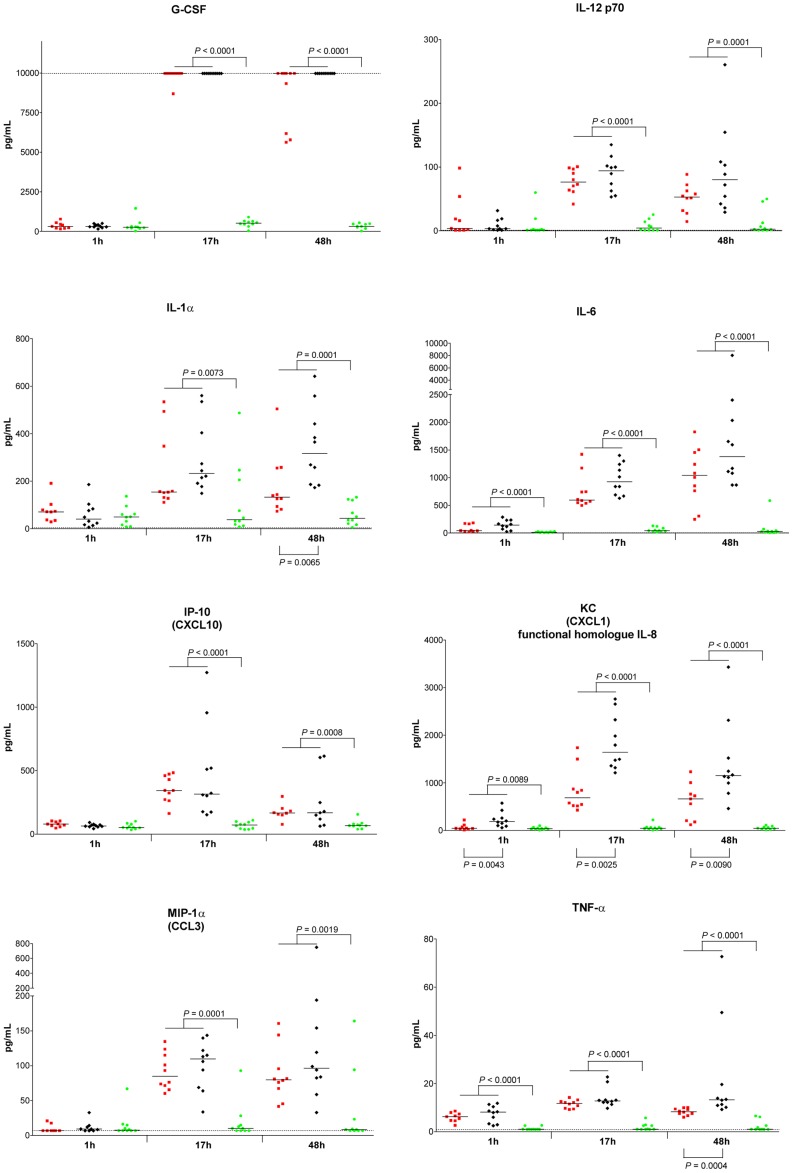
Serum cytokine levels elevated due to S. aureus bacteraemia in mice at indicated time points.Mice were inoculated intravenously with S. aureus at the LD50 inoculum. Each symbol represents a single mouse. Red squares represent surviving infected mice (n = 10); black diamonds represent non-surviving infected mice (n = 10); green circles represent placebo-inoculated mice (n = 10). Median values are presented by horizontal lines. Statistically significant differences in cytokine levels between infected mice versus placebo-inoculated mice are indicated above the x-axis. Statistically significant differences in cytokine levels between surviving infected mice versus non-surviving infected mice are indicated below the x-axis. P-values < 0.01 (Mann-Whitney U test) are shown. h, hours.